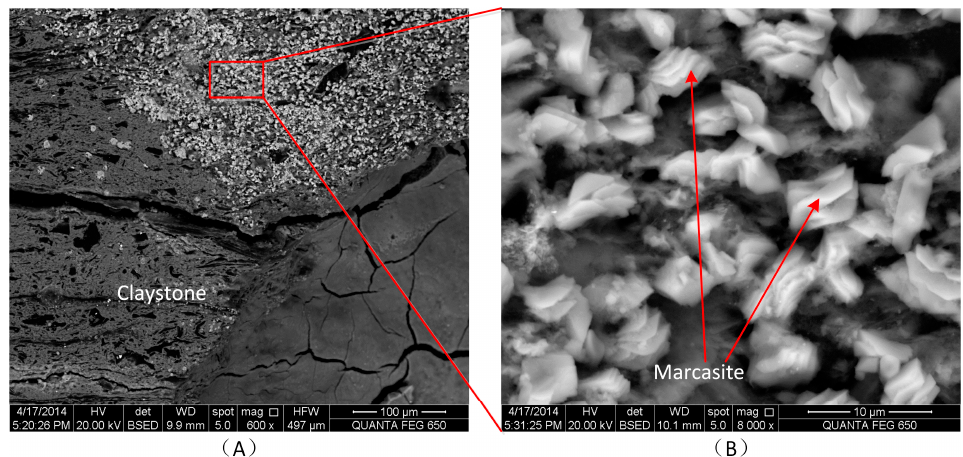
Figure 10. SEM back-scattered electron images of marcasite in C25-f. ( A ) Marcasite and claystone; ( B ) Marcasite.